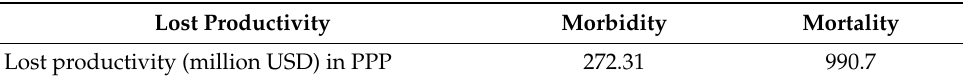
Table 10. Lost productivity attributable to alcohol in million USD, 2017.